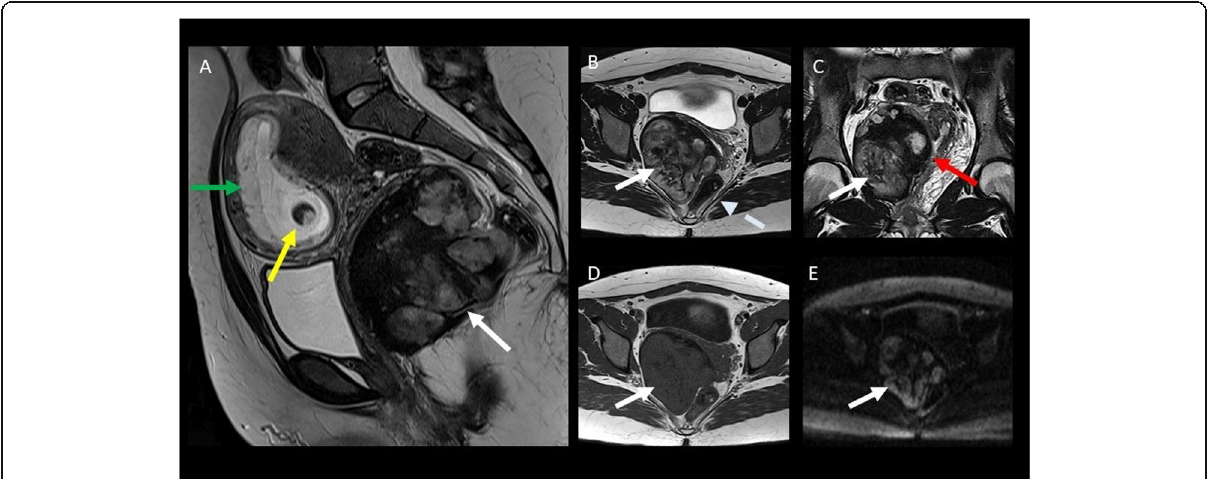
Fig. 13 A 22-year-old female patient with pelvic DT onset during pregnancy (white arrow). T2wi (sagittal ( a ), axial ( b ), and coronal ( c ) plane) showed a soft tissue well-defined mass with a heterogeneous hyperintense signal with internal band-like low-signal intensity. The lesion is characterized by mild restriction on diffusion-weighted image sequences ( e ) and isointensity signal to the muscle on T1wi ( d ). The lesion did not infiltrate the rectum (dot arrow in b ) but was not cleavable from the lateral wall of the vagina (red arrow in c ). Green arrow in a showed the anterior placenta, and yellow arrow in a showed the fetus head